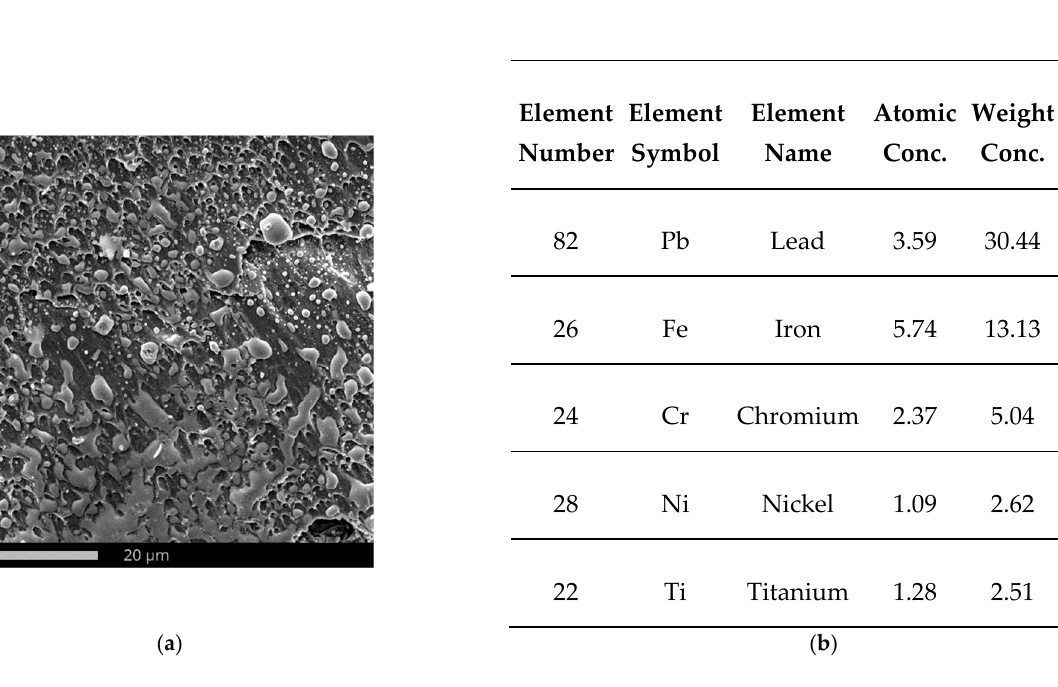
projectile exit ( a ) and listing the most important chemical elements on the analyzed surface ( b ) de ‐